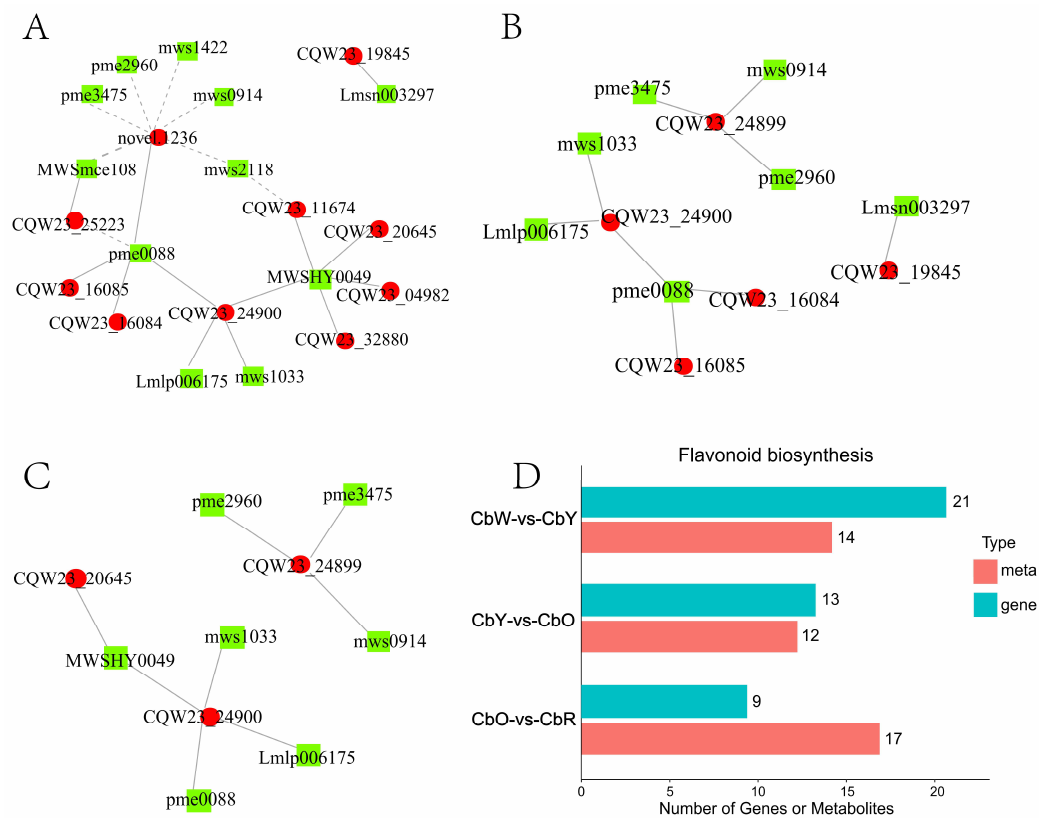
Figure 7. Correlation analysis of transcriptome and metabolome. ( A – C ) Interactions between genes and metabolites in CbW-vs-CbY, CbY-vs-CbO and CbO-vs-CbR; ( D ) pathways co-enriched to genes and metabolites in CbW-vs-CbY, CbY-vs-CbO and CbO-vs-CbR.